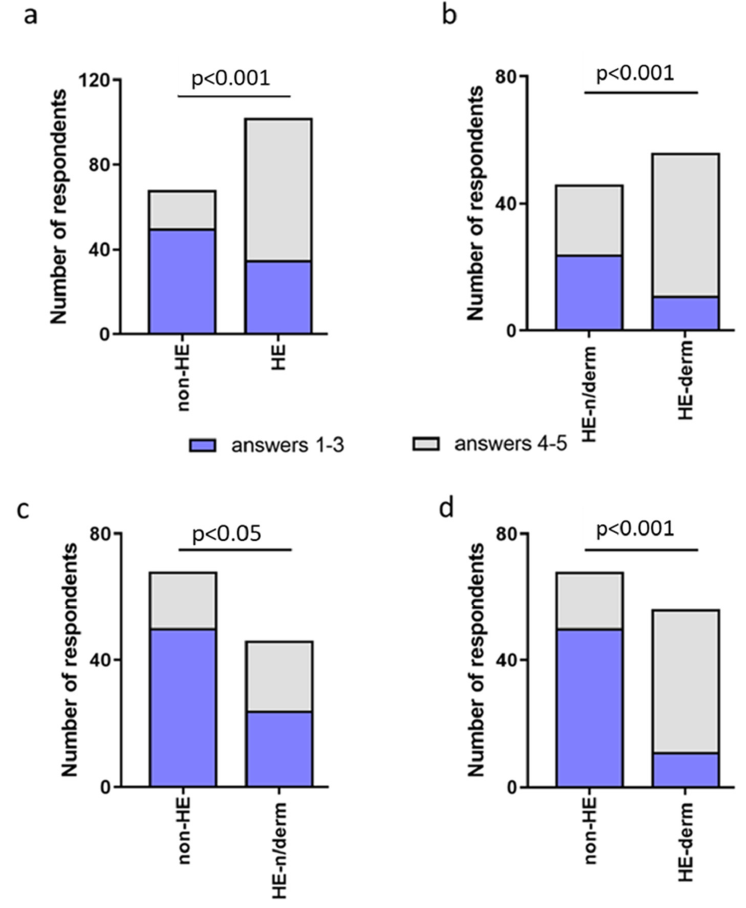
Figure 25. The number of respondents in study groups who chose the answers 1–3 and 4–5 in the assessment of quality of life: ( a ) non-HE vs. HE; ( b ) HE n/derm vs. HE-derm; ( c ) non-HE vs. HE n/derm; ( d ) non-HE vs. HE-derm.